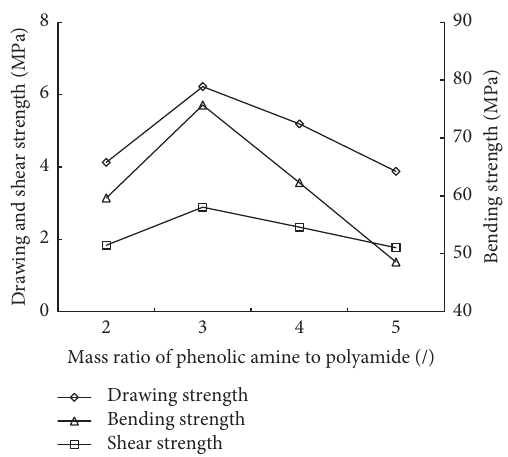
Figure 4: Mass ratio of the epoxy resin to the curing